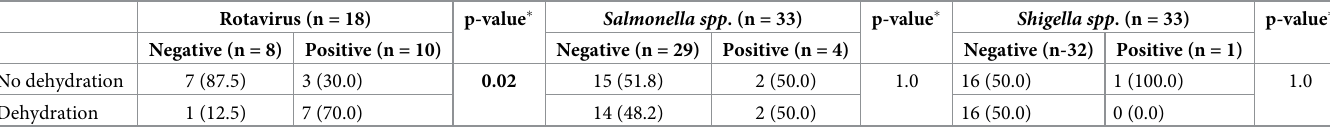
Table 4. Association between etiologic pathogens and level of dehydration among U5 children hospitalized with acute